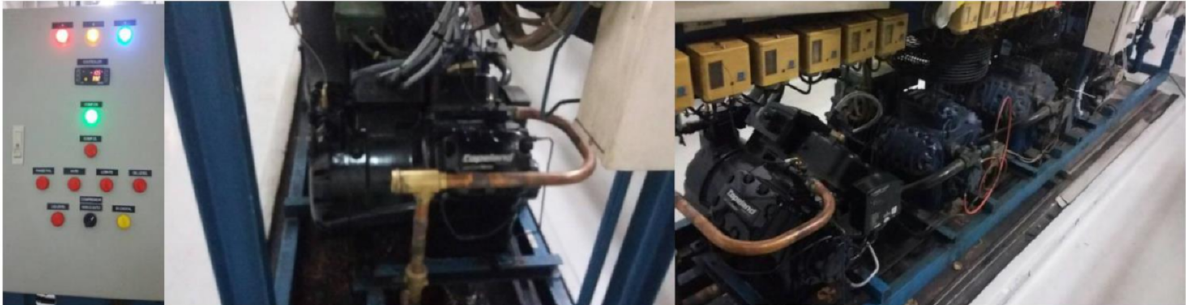
Figure 4. Digital compressor rack with digital compressor and digital controller No.1 (R22).